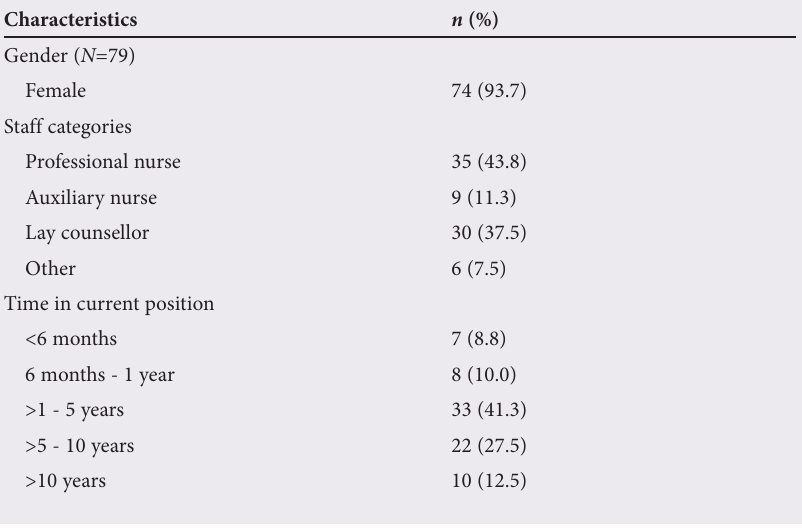
Table 4. Characteristics of healthcare workers ( N =80) Characteristics